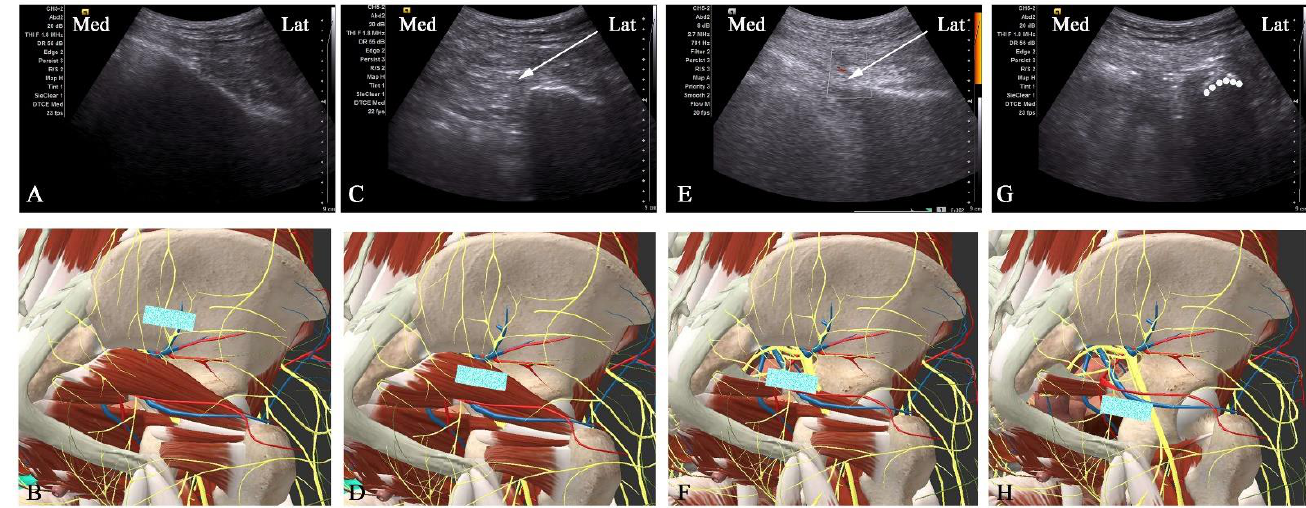
Figure 3. The key anatomical locations for ultrasonic transducer placement (blue identification in ( B , D , F , H )) and the corresponding ultrasound images ( A , C , E , G ). ( A , B ) The ultrasonic transducer is placed in the ilium and showed continuous hyperechoic lines. ( C , D ) The transducer is moved downward parallel to the greater sciatic foramen and then reveals the piriformis (white arrow marks). ( E , F ) The transducer continues to move parallel to the ischial spine so that the internal pudendal artery, a branch of the internal iliac artery adjacent to the pudendal nerve, could be seen on the color Doppler. The inserted needle (white arrow), lying laterally to the internal artery, visualizes the puncture path and the target pudendal nerve. ( G , H ) The transducer is slowly moved parallel to the hypoechoic crescent (dashed line), which shows the area underneath the ischial spine between the ischial spine and ischial tuberosity. This helps us to identify the position of the ischial spine and pudendal nerve.